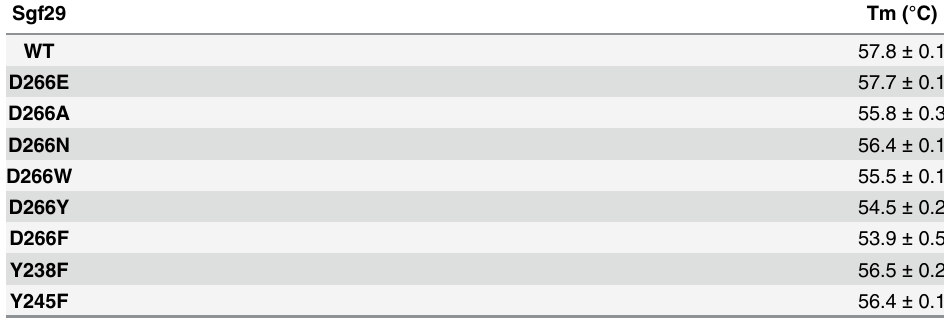
Table 1. Tm values for Sgf29 and its variants as determined by DSF.